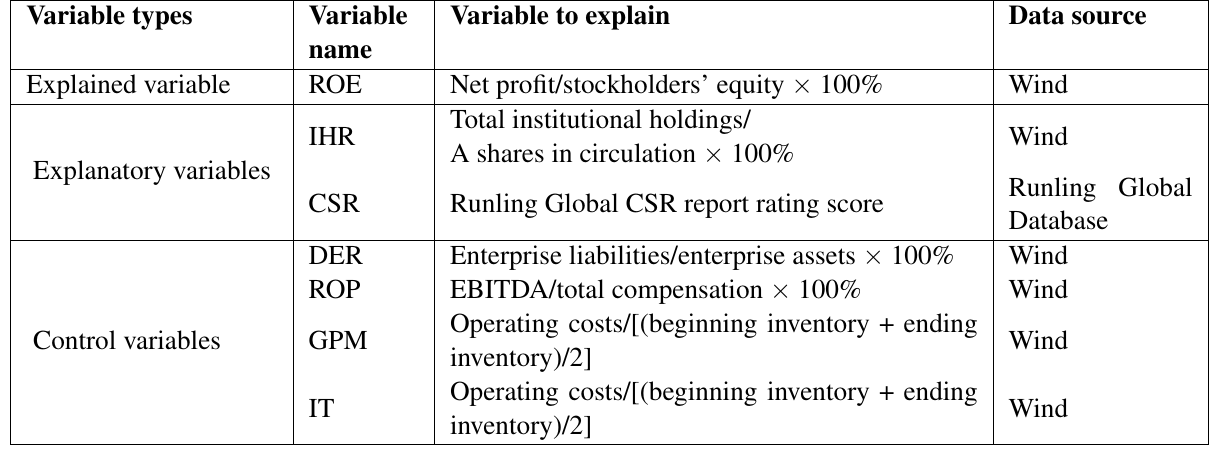
Table 3 Definition of investigate